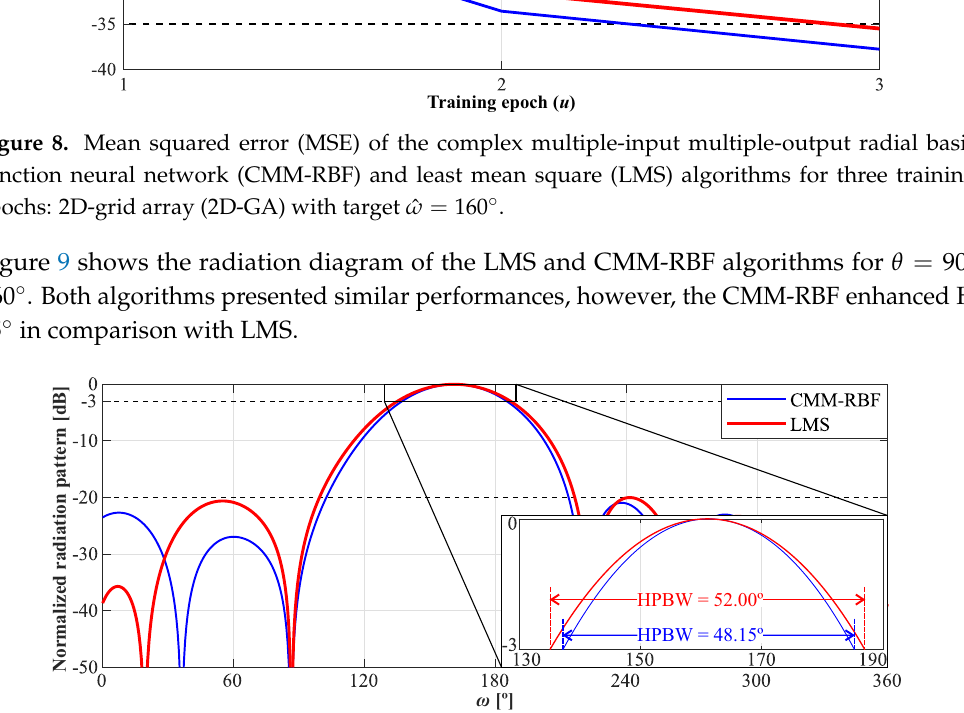
Figure 9. Normalized radiation pattern of the complex multiple-input multiple-output radial basis function neural network (CMM-RBF) and least mean square (LMS) algorithms for the 2D-grid array (2D-GA) with θ = 90 ◦ and ˆ ω = 160 ◦ .